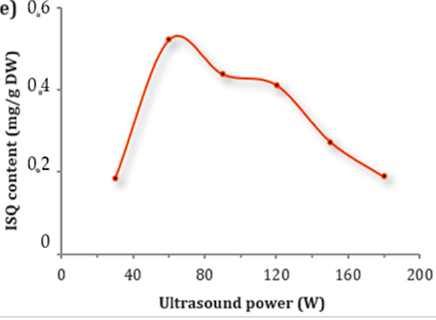
Figure 2. The effects of UAE parameters on the recovery of ISQ (mg/g) from E. alata in single-factor experiments: ethanol concentration ( a ), solid–liquid ratio ( b ), ultrasonic temperature ( c ), ultrasonic time ( d ), ultrasound temperature ( e ), and ultrasound power.